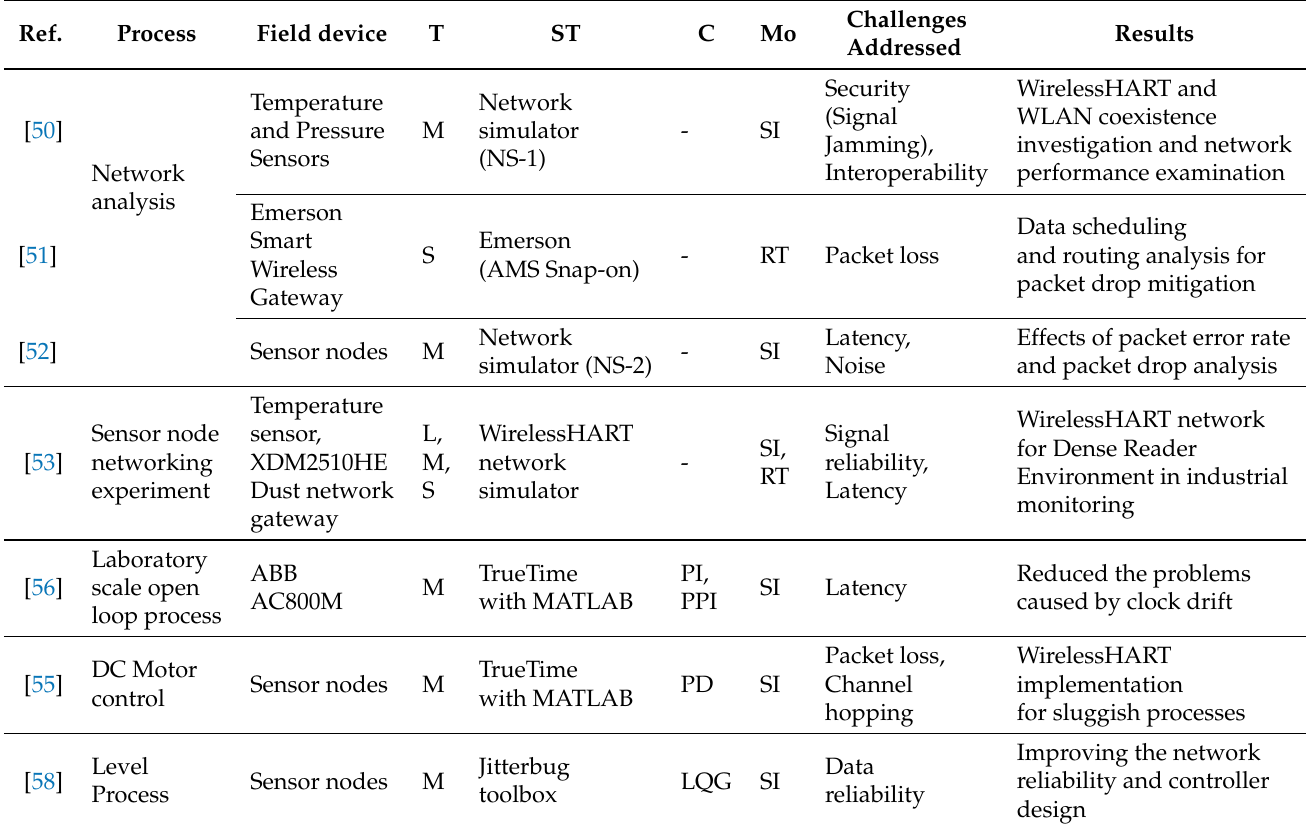
Table 5. Summary of WirelessHART for monitoring and control applications in the simulation environment.